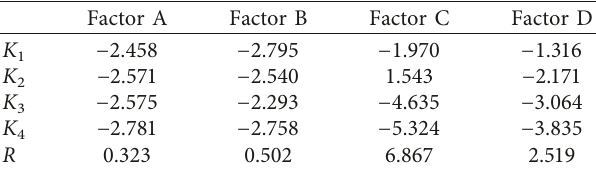
Table 5: K i and R for different temperature-control factors.